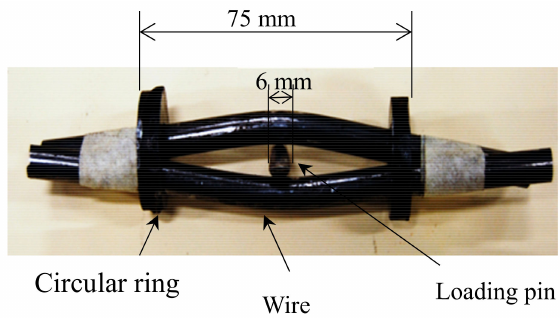
Figure 6. Photograph of the long-term cable-bolt coupon.